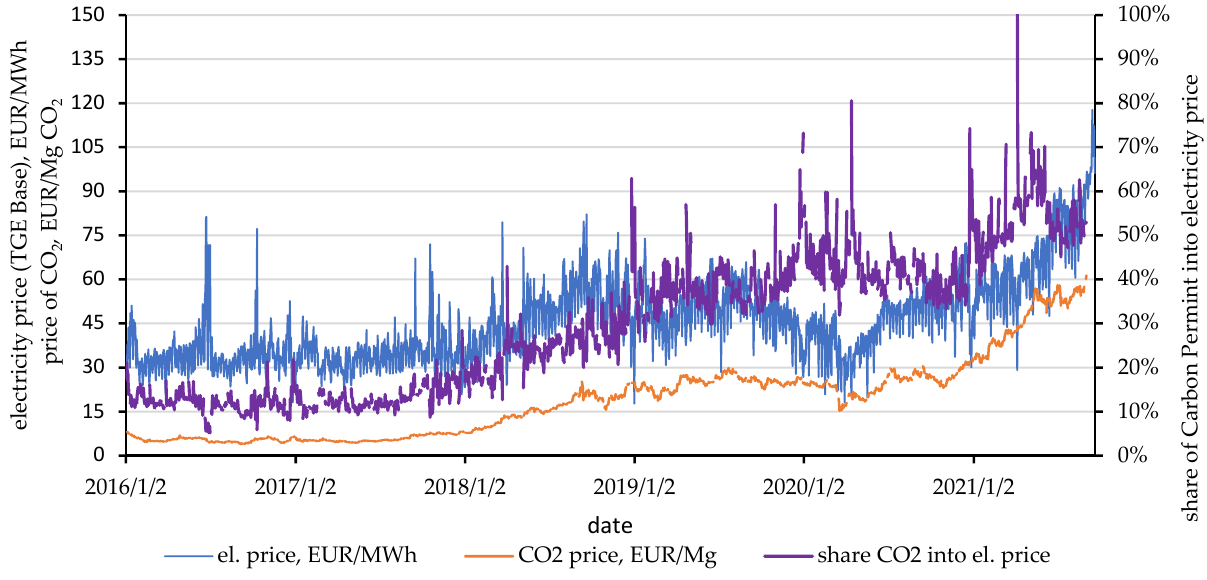
el. price, EUR/MWh CO2 price, EUR/Mg share CO2 into el. price Figure 9. Electricity prices according to Polish Power Exchange (TGE Base index)—instead of price share, share of purchase costs. Source: own study based on [38,39]. photovoltaic (PV) sources in 2021 were significantly lower than the TGE Base index (Figure 10).